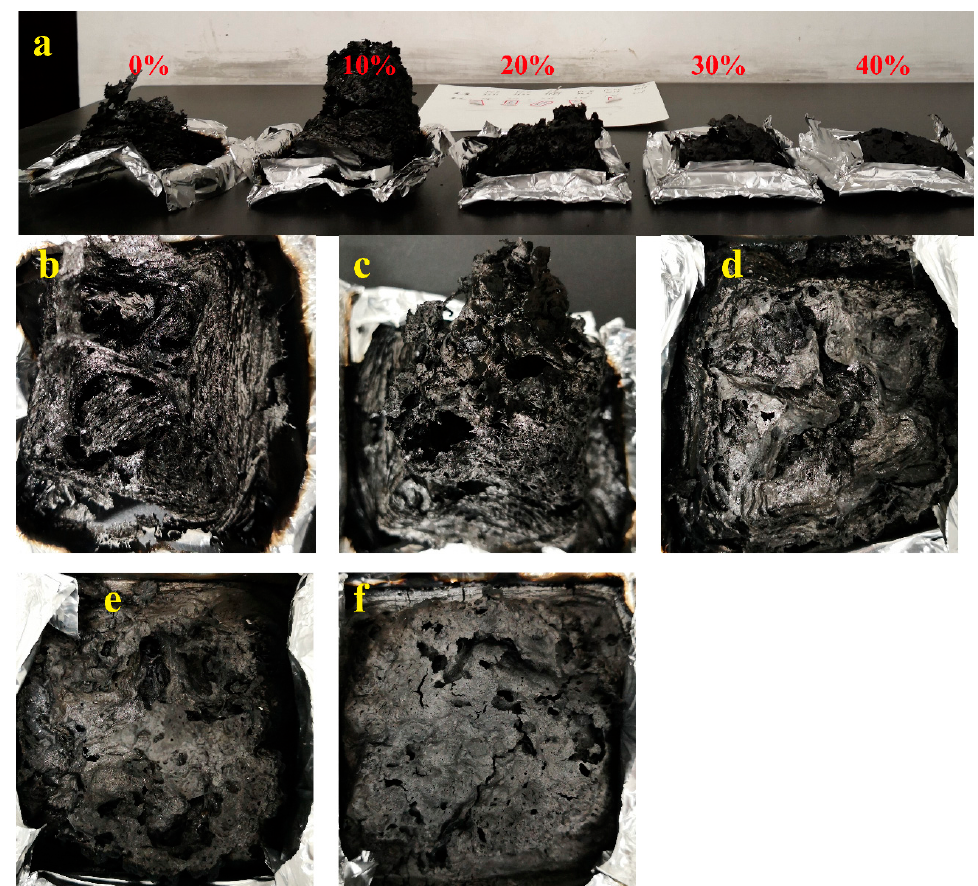
Figure 3. ( a ) Digital photos of char formation for wood–PC composites after cone calorimeter and the surface morphology of char formed from the resulting composites with different wood contents: ( b ) 0%; ( c ) 10%; ( d ) 20%, ( e ) 30% and ( f ) 40%.